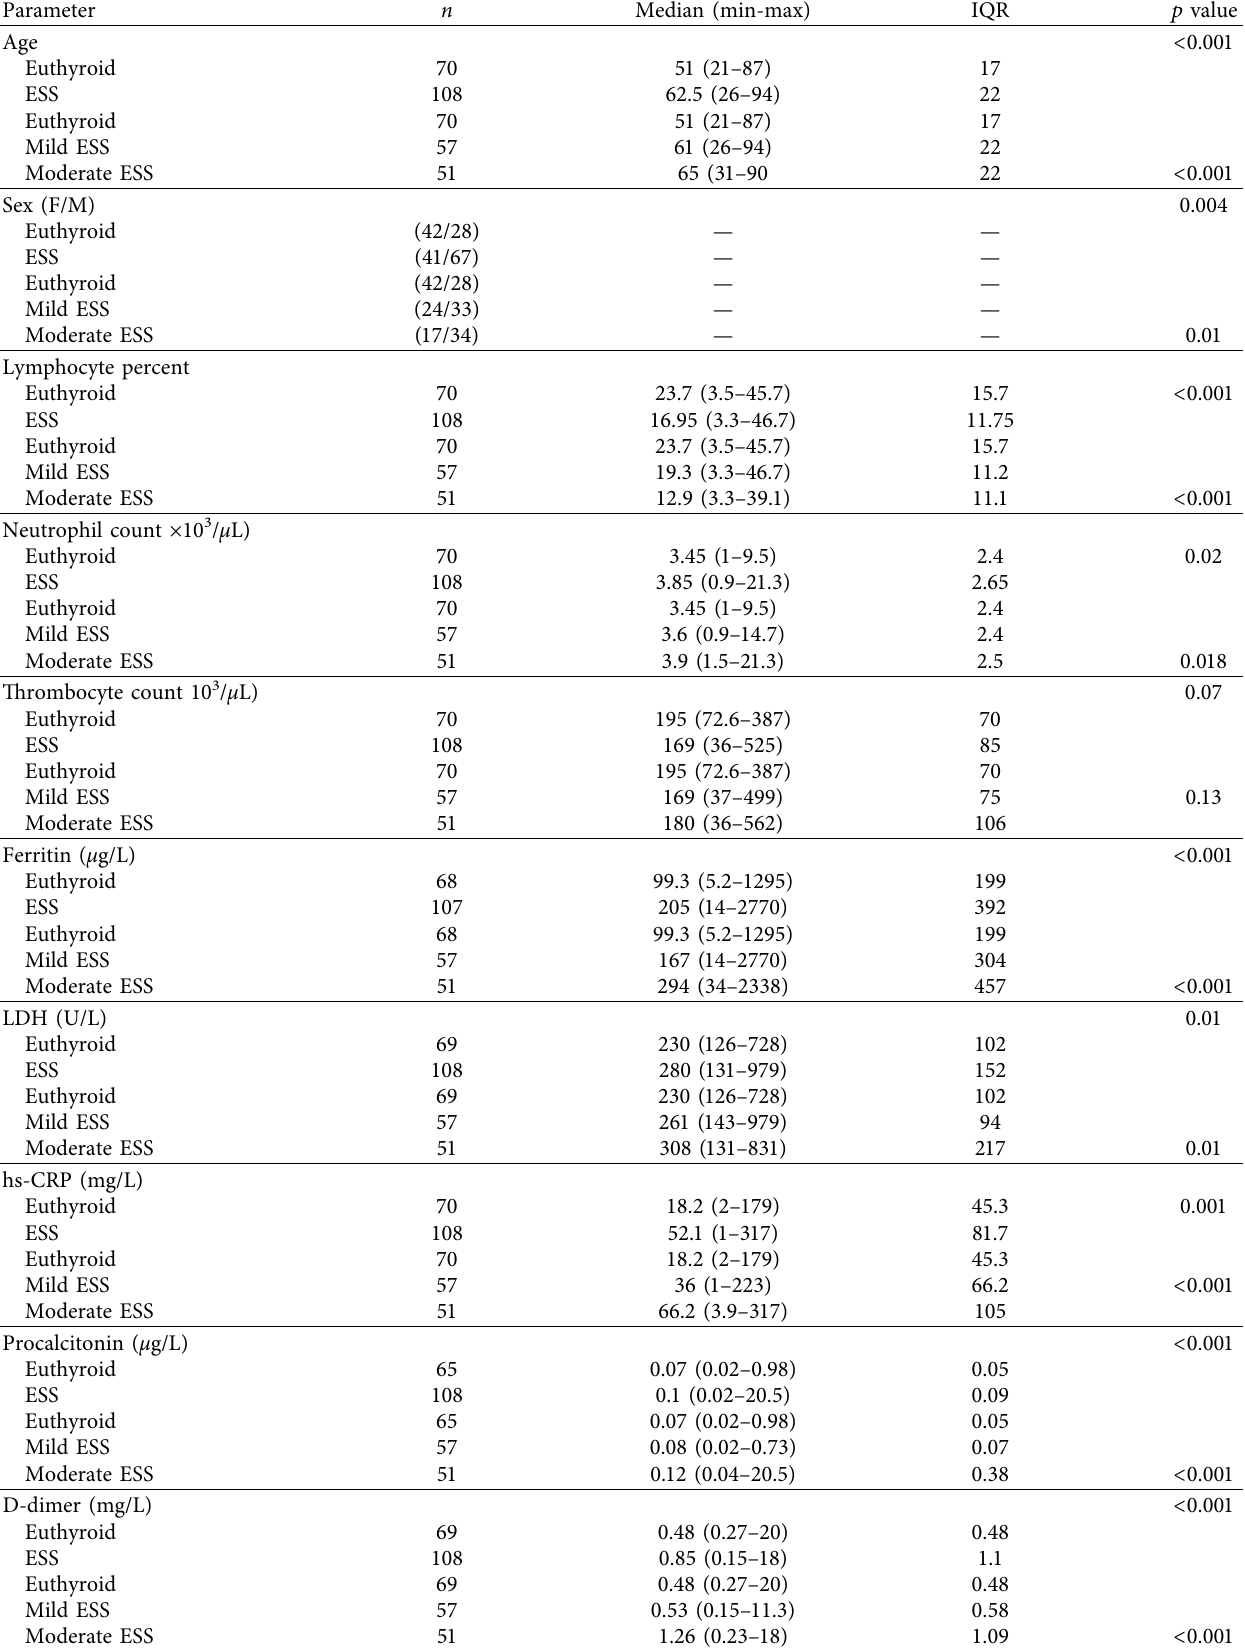
Table 3: Baseline characteristics and laboratory parameters of euthyroid patients with ESS and its